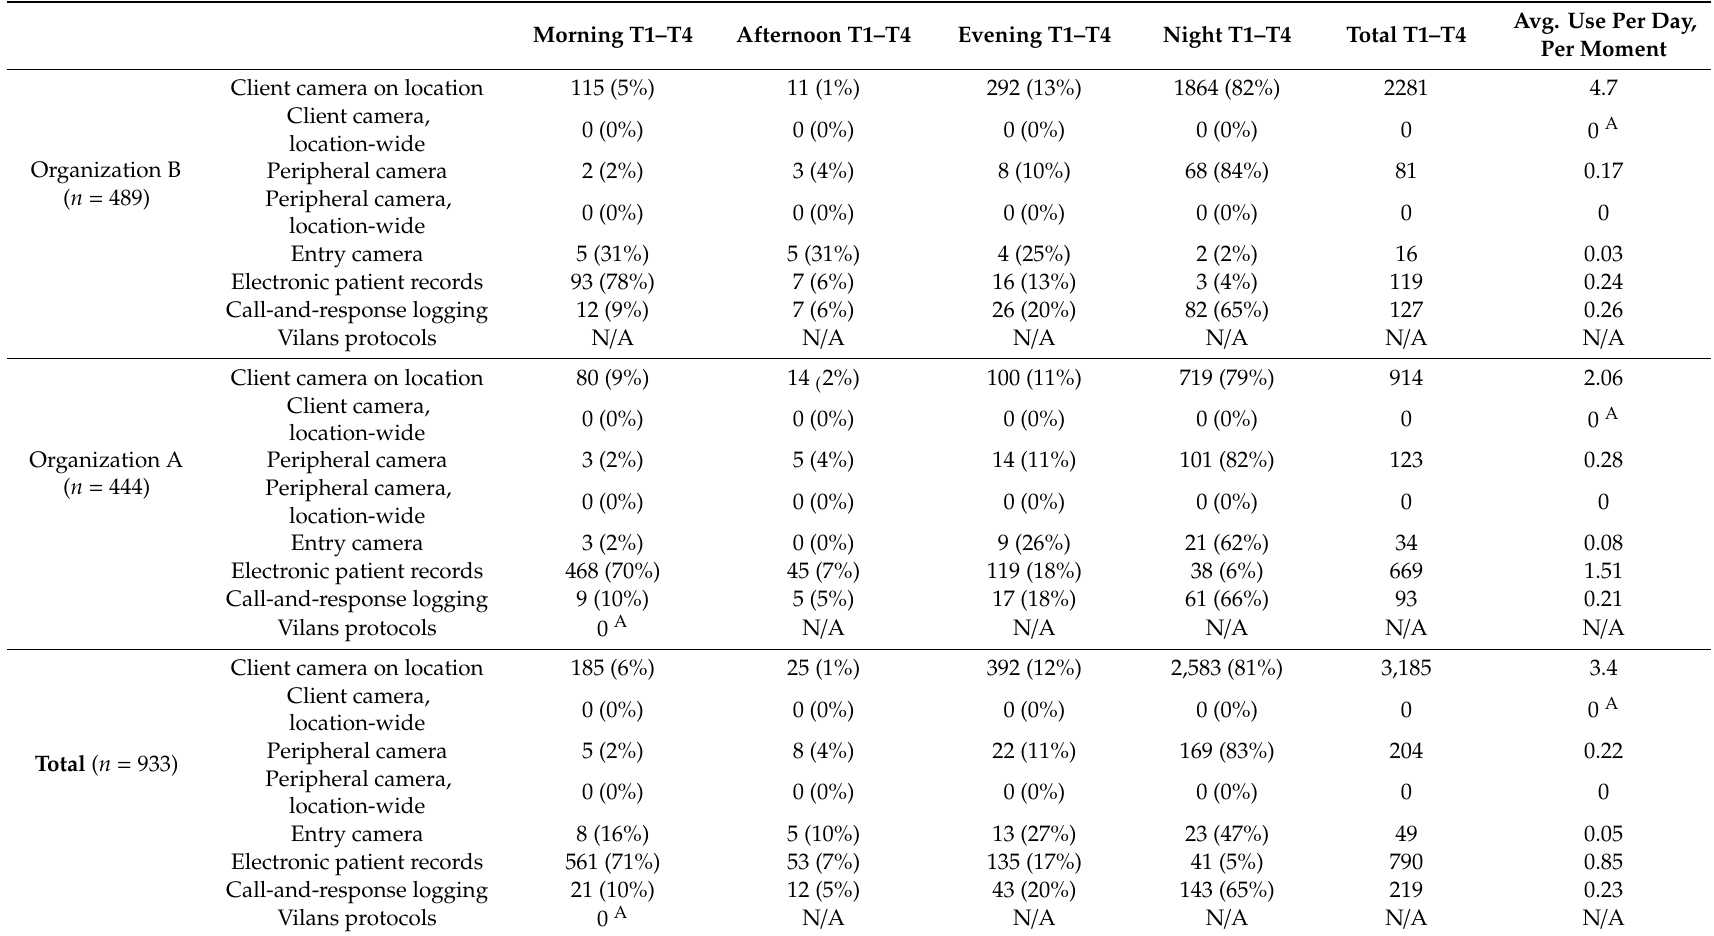
Table 3. Functionalities used per